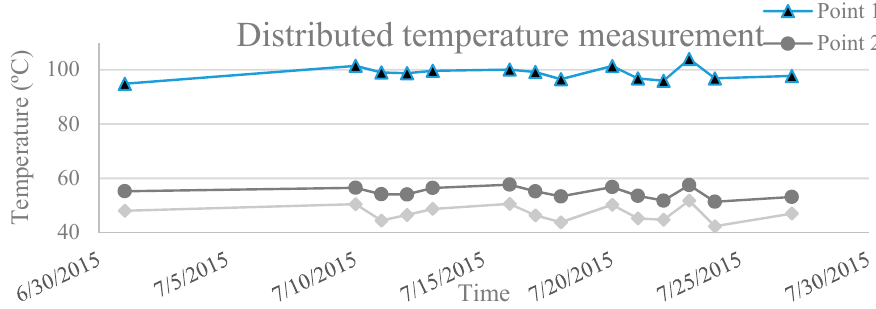
Figure 10. Graphical representation of temperatures for points 1, 2 and 3 as a function of time.